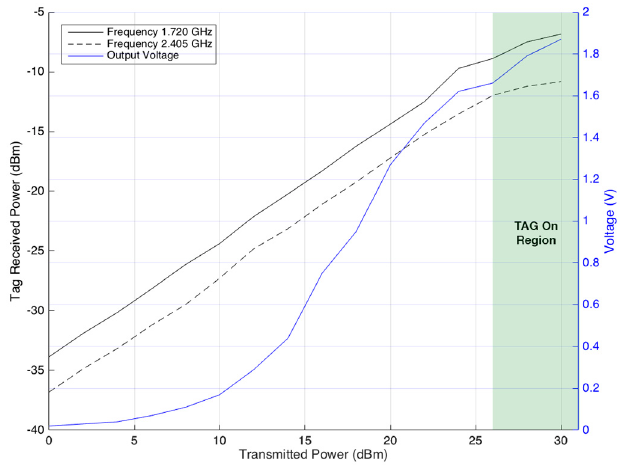
Figure 10. WPT at distance of 300 cm.